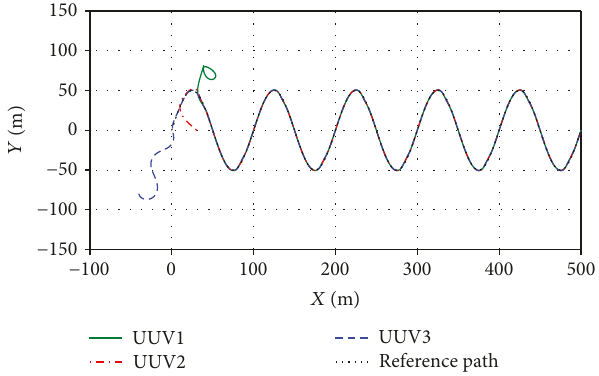
Figure 3: Paths of 3 UUVs sine curves.